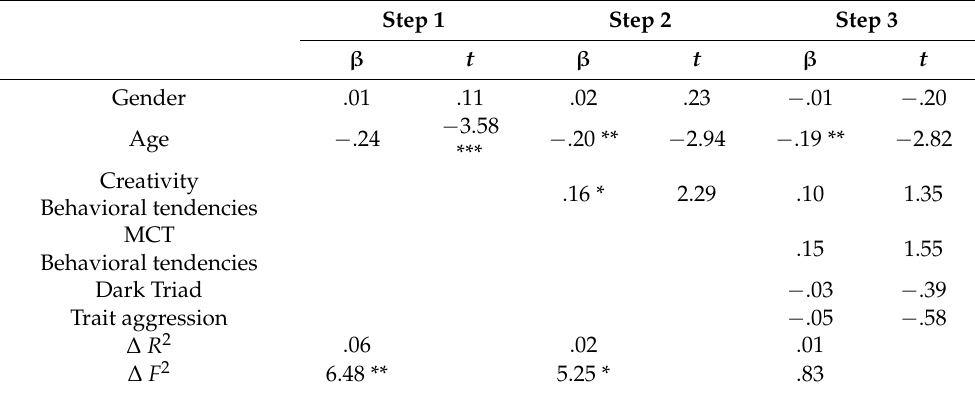
Table 3. Results of hierarchical regression analysis using gender (0 = female, 1 = male), age, and the other scale scores as independent variables on MCT